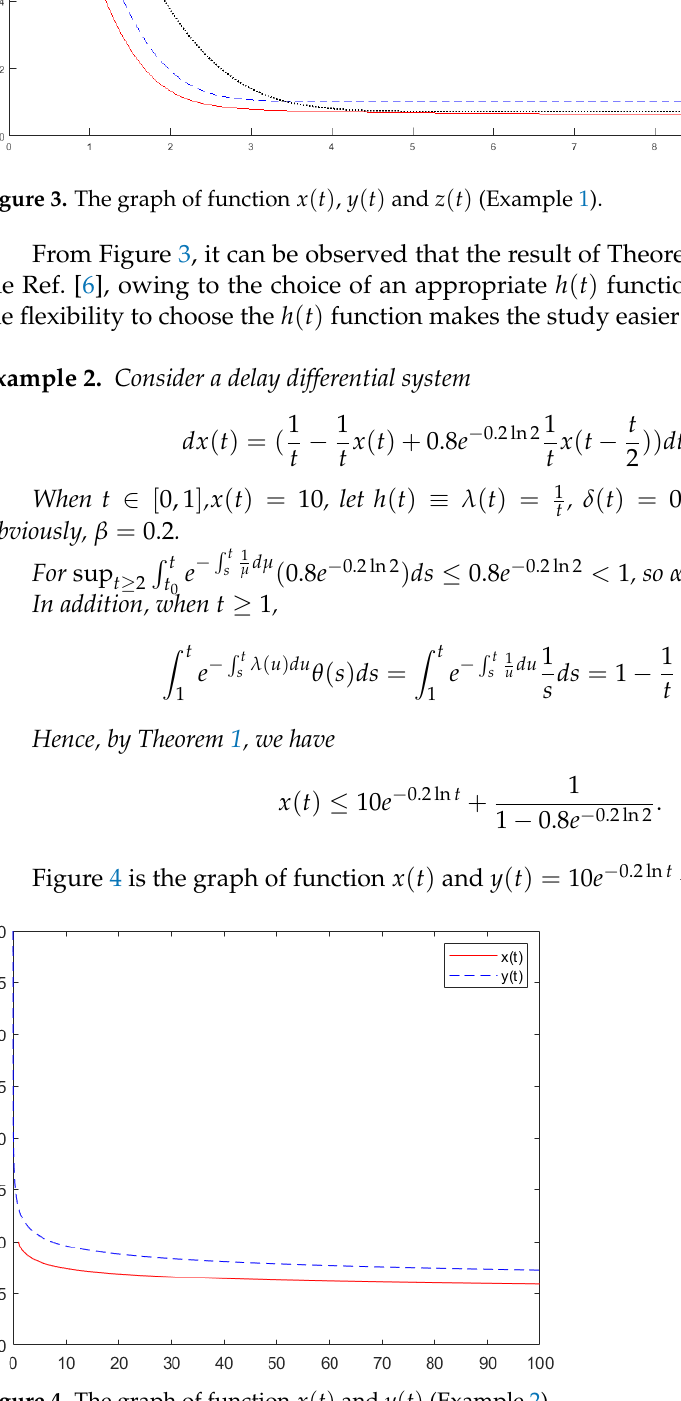
Figure 4. The graph of function x ( t ) and y ( t ) (Example